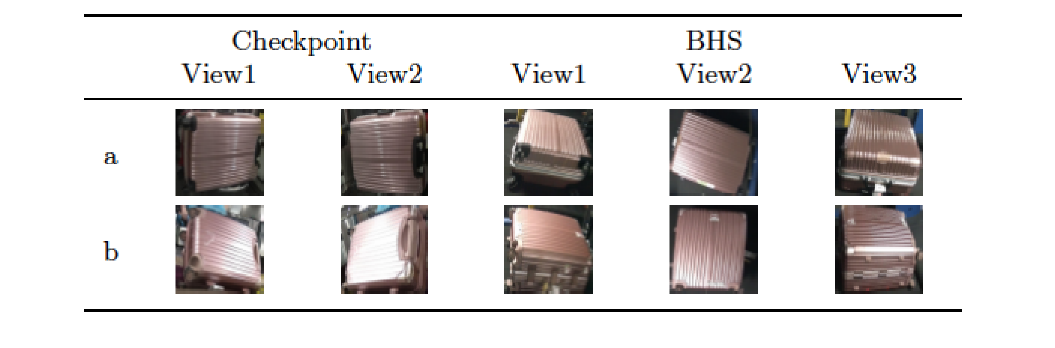
Figure 6. Samples of inter-class similarity on MVB (Multi View Baggage) dataset. Images in each row are from one identity. ( a ) different image views of the baggage. ( b ) different image views of the another baggage [1].